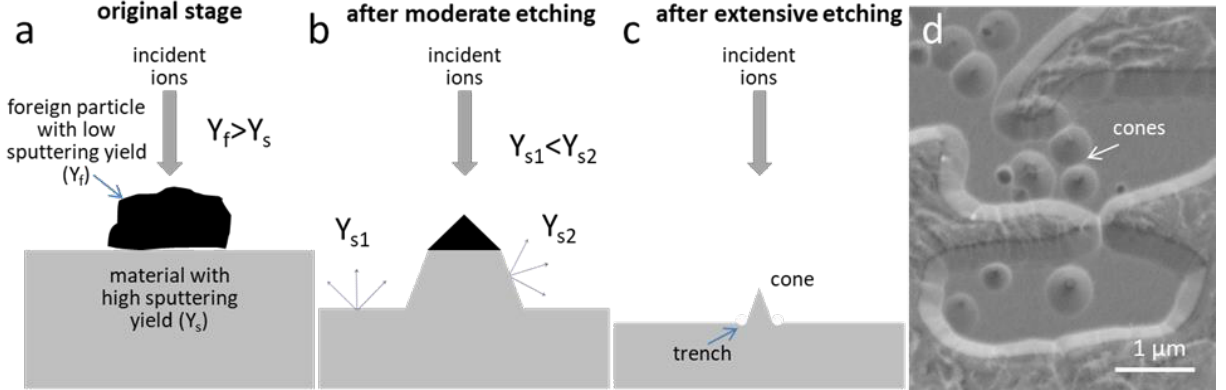
Figure 10. Scheme showing stages of cone formation during ion etching of substrate covered by a micrometer-sized foreign particle. If the foreign particle is located on the substrate surface, then it prevents the etching of the substrate area underneath the seed ( a ). Therefore, a step will be formed under the edge of the particle ( b ). As the particle itself shrinks, the step will be inclined. When the shielding particle is eroded away, a sharp cone of matrix material remains ( c ). Top view SEM image ( d ) shows the cones formed on the surface of carbides in D2 substrates during RF ion etching in the CC7 deposition system.